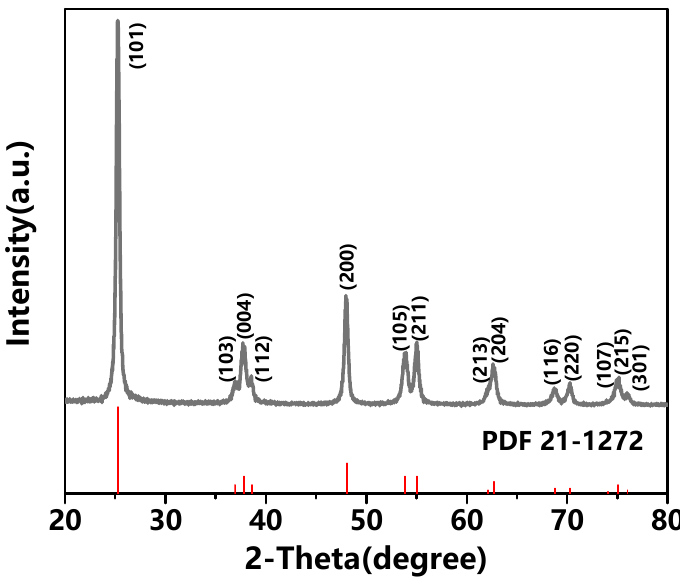
Figure 4. XRD pattern of PVDF(TBT)/PVP(TBT)-GQDs photocatalyst.